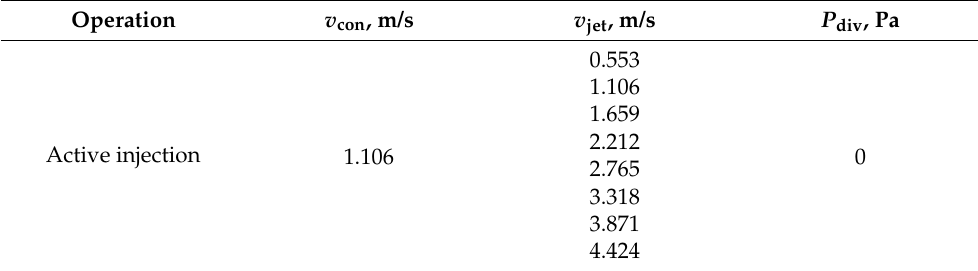
Table 8. The operating conditions in active injection of